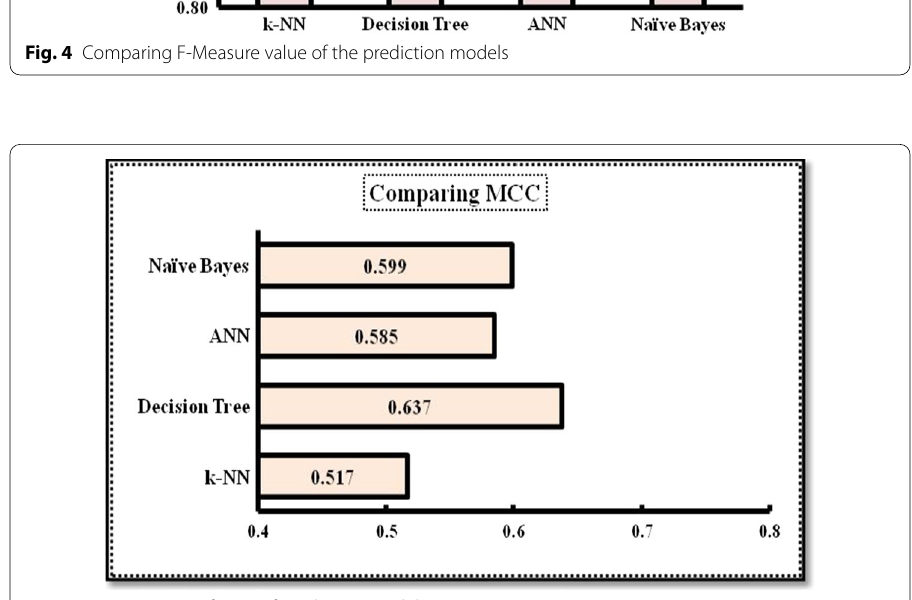
Fig. 5 A comparison of MCC of prediction